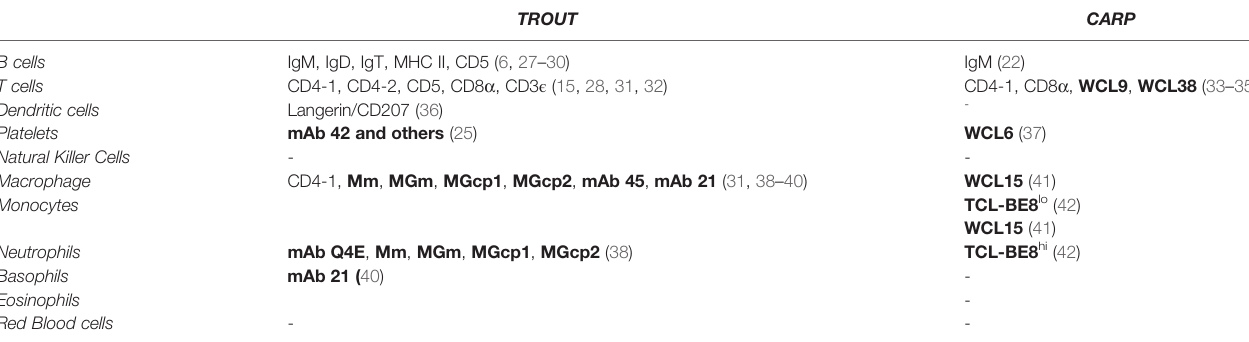
TABLE 1 | Summary of available antibodies speci fi c to rainbow trout Oncorhynchus mykiss or common carp Cyprinus carpio leukocytes.